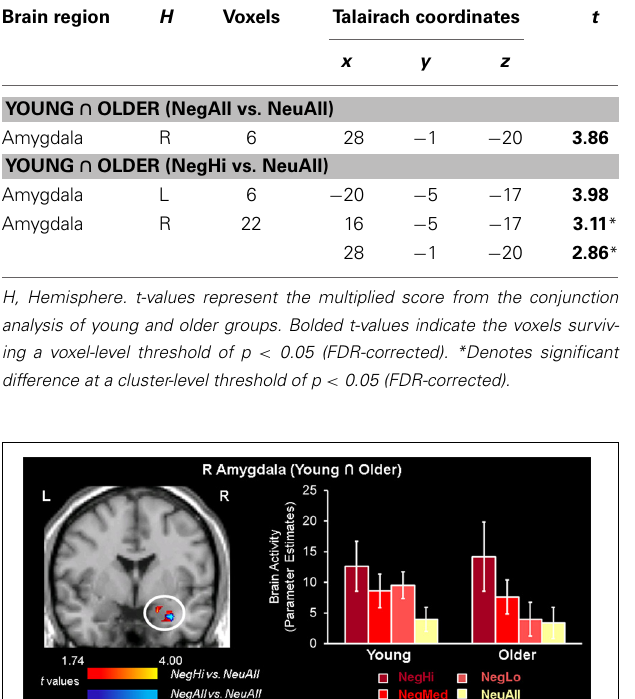
FIGURE 1 | Common amygdala activation for high arousing stimuli in young and older adults. Common engagement of the right amygdala by young and older groups was identified using conjunction analysis based on a region of interest approach, where both young and older groups showed common activity for negative vs. neutral (blue area) and high arousing negative vs. neutral (red area) stimuli ( p = 0 . 0025). The bar graph illustrates the parameter estimates corresponding to the peak voxel in the area of R AMY commonly activated by young and older adults for NegAll vs. NeuAll contrast. L, left; R, right; NegHi, Negative High Arousal; NegMed, Negative Medium Arousal; NegLo, Negative Low Arousal; NegAll, Negative All; NeuAll, Neutral